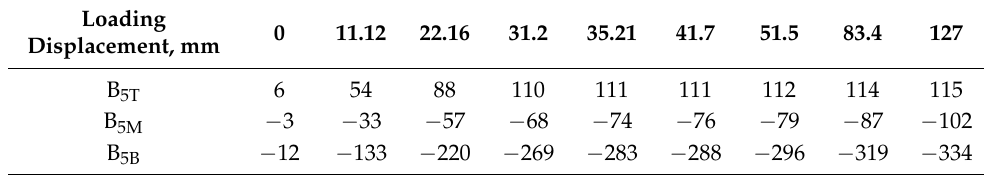
Table 2. Concrete Strain at middle-span section of